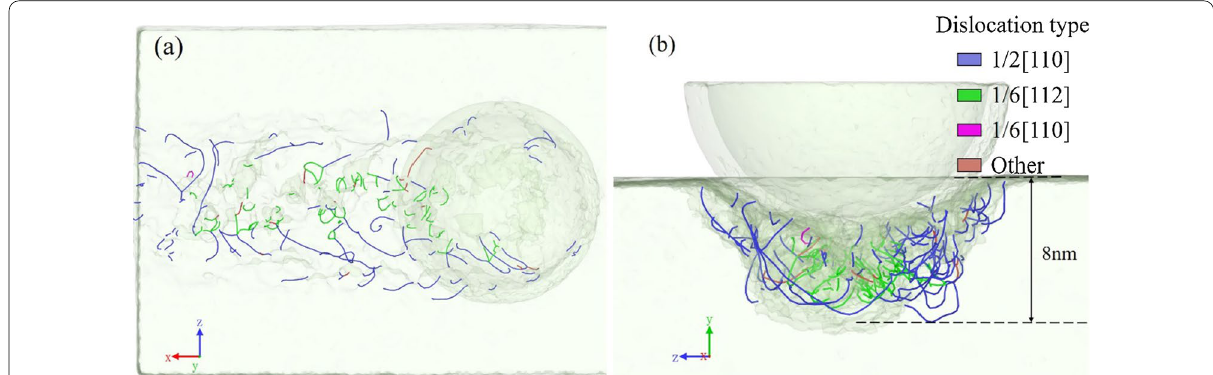
Fig. 5 Perspective views of dislocation distribution in the machined subsurface, in a y -direction and b x -direction